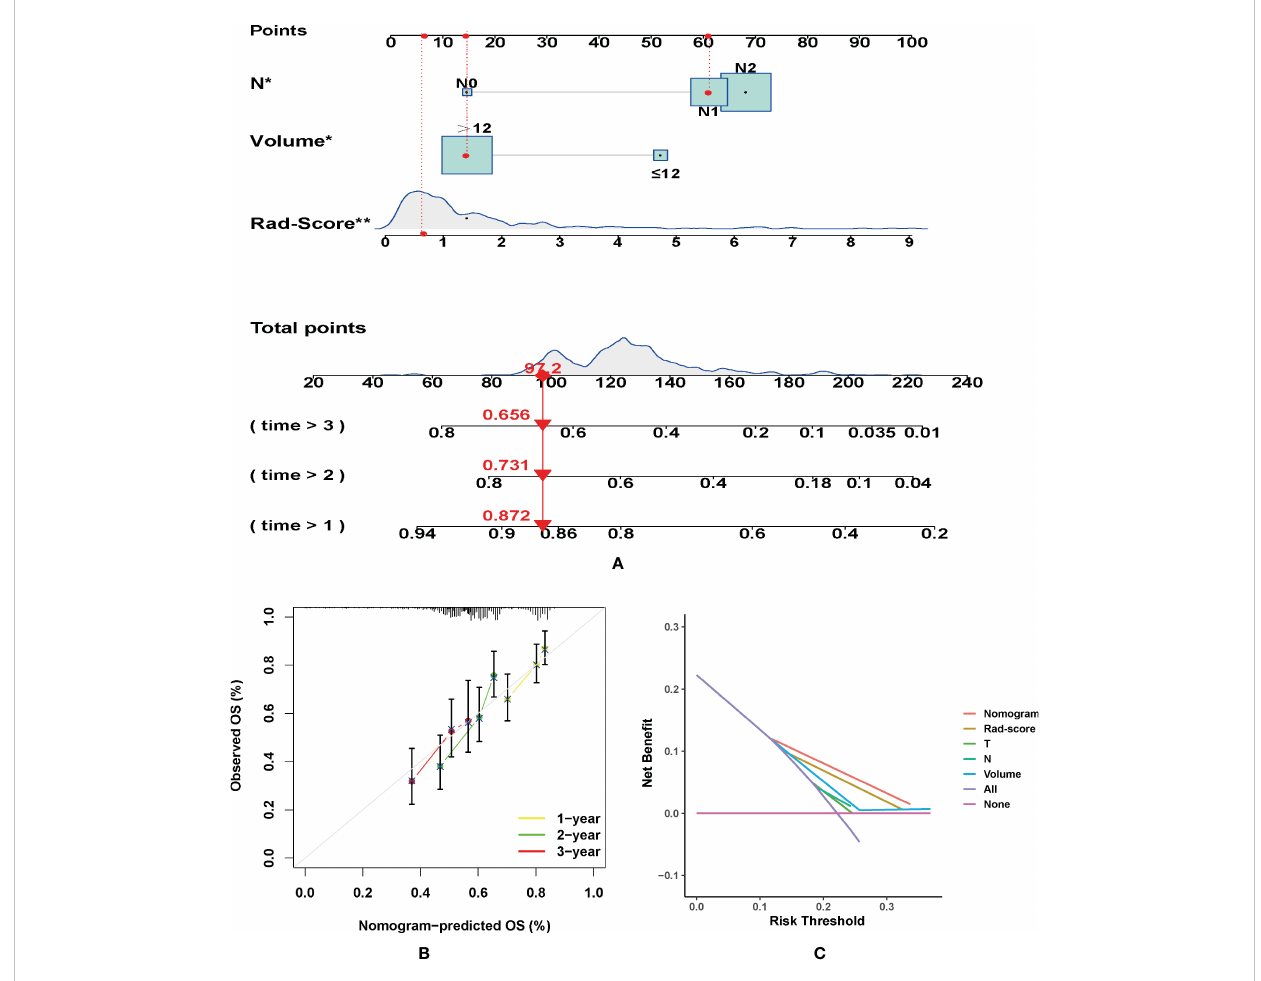
FIGURE 5 (A) Nomogram for predicting the overall survival (OS) of advanced laryngeal cancer (LC) patients. For each patient, lines are drawn downward to assess the points received from the four prognostic factors in the nomogram. The sum of these points is shown on the “ Total points ” axis. A line is drawn downward to determine the 1-, 2-, and 3-year OS of LC patients. (B) Calibration plot for the internal validation of the nomogram. The Y-axis exhibits actual survival. The X-axis exhibits nomogram-estimated survival. The dotted line (45° diagonal line) signi fi es full agreement between actual and observed probabilities. (C) Clinical net bene fi t of the nomogram, radiomic score, and other clinical features (including T, N, and Volume). *P =0.04, **P =0.008.